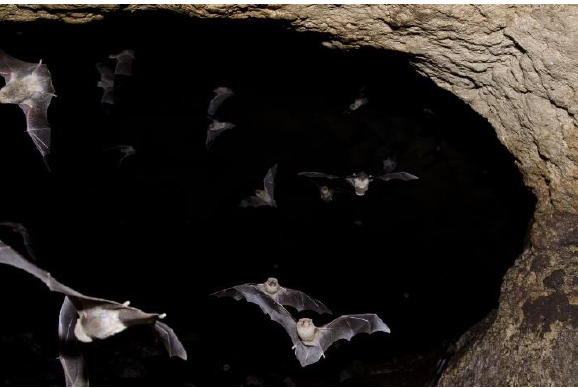
Figure 2. Bats inside Grotta dei Pipistrelli. Picture by T. Puma The karst cavity opens on a rocky wall overhanging the Calcinara stream, about 10 m from the watercourse (Fig. 3), in the Miocene “Calcari di Siracusa” formation (Grasso and Lentini, 1982, Schilirò et al., 2002).